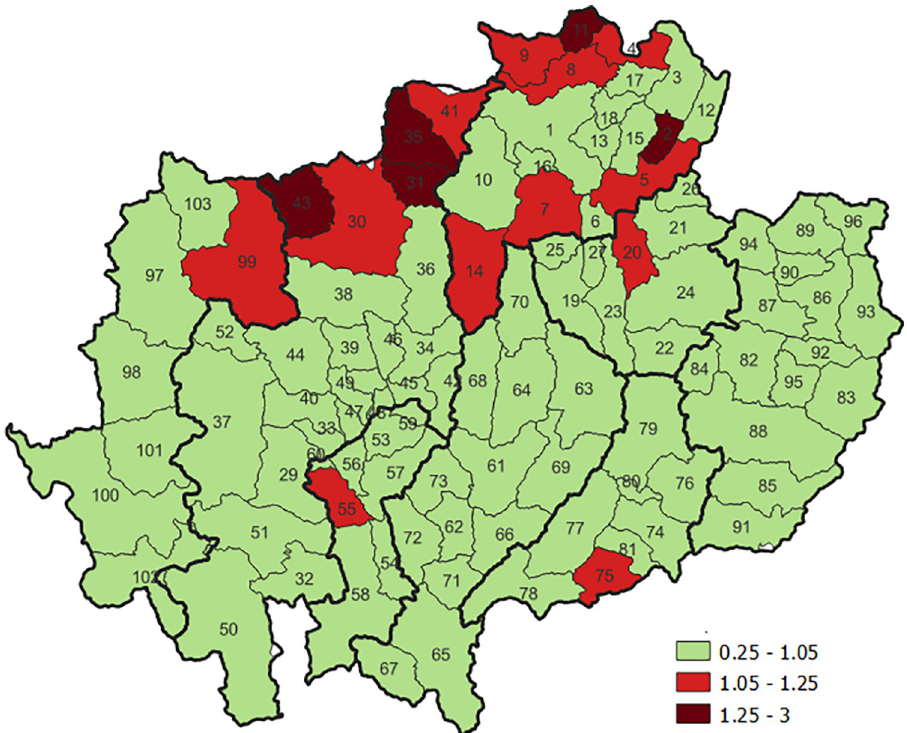
Fig 4. Geographic variation in relative risk of cervical cancer by district in upper northern Thailand. The map in this figure was produced using QGIS version 3.4.15–1. Source of shapefile: https://data.humdata.org/dataset/